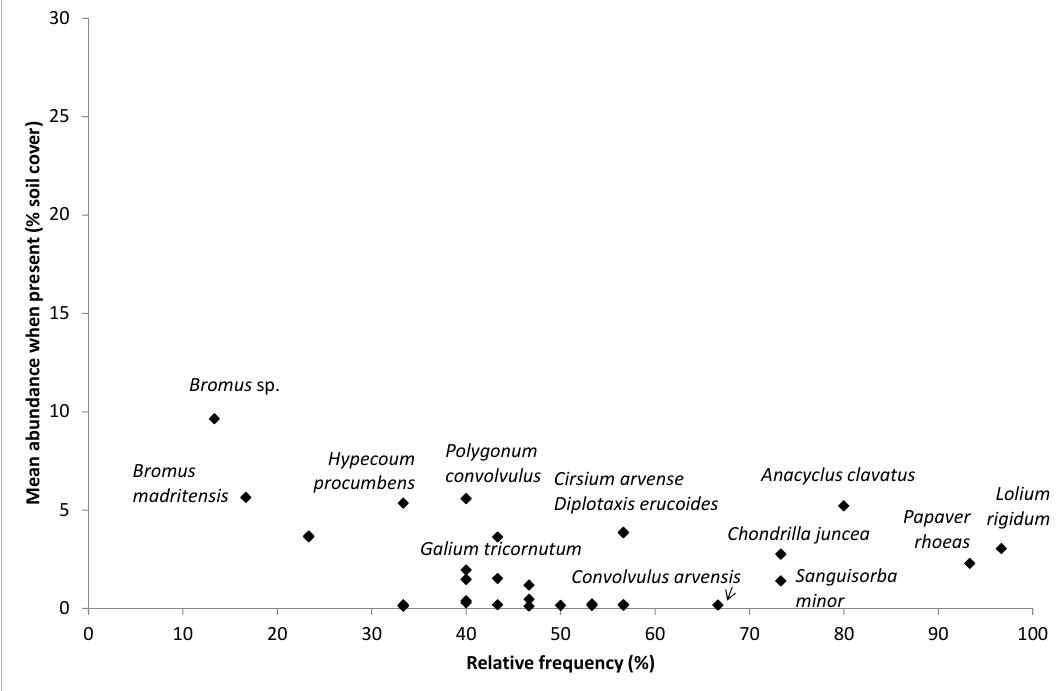
Figure 5. Species relative frequency and mean abundance when present in cereal fields after cropping sainfoin (CS). Data of years 2011-14 pooled together. Named species are the most abundant and most frequent ones.